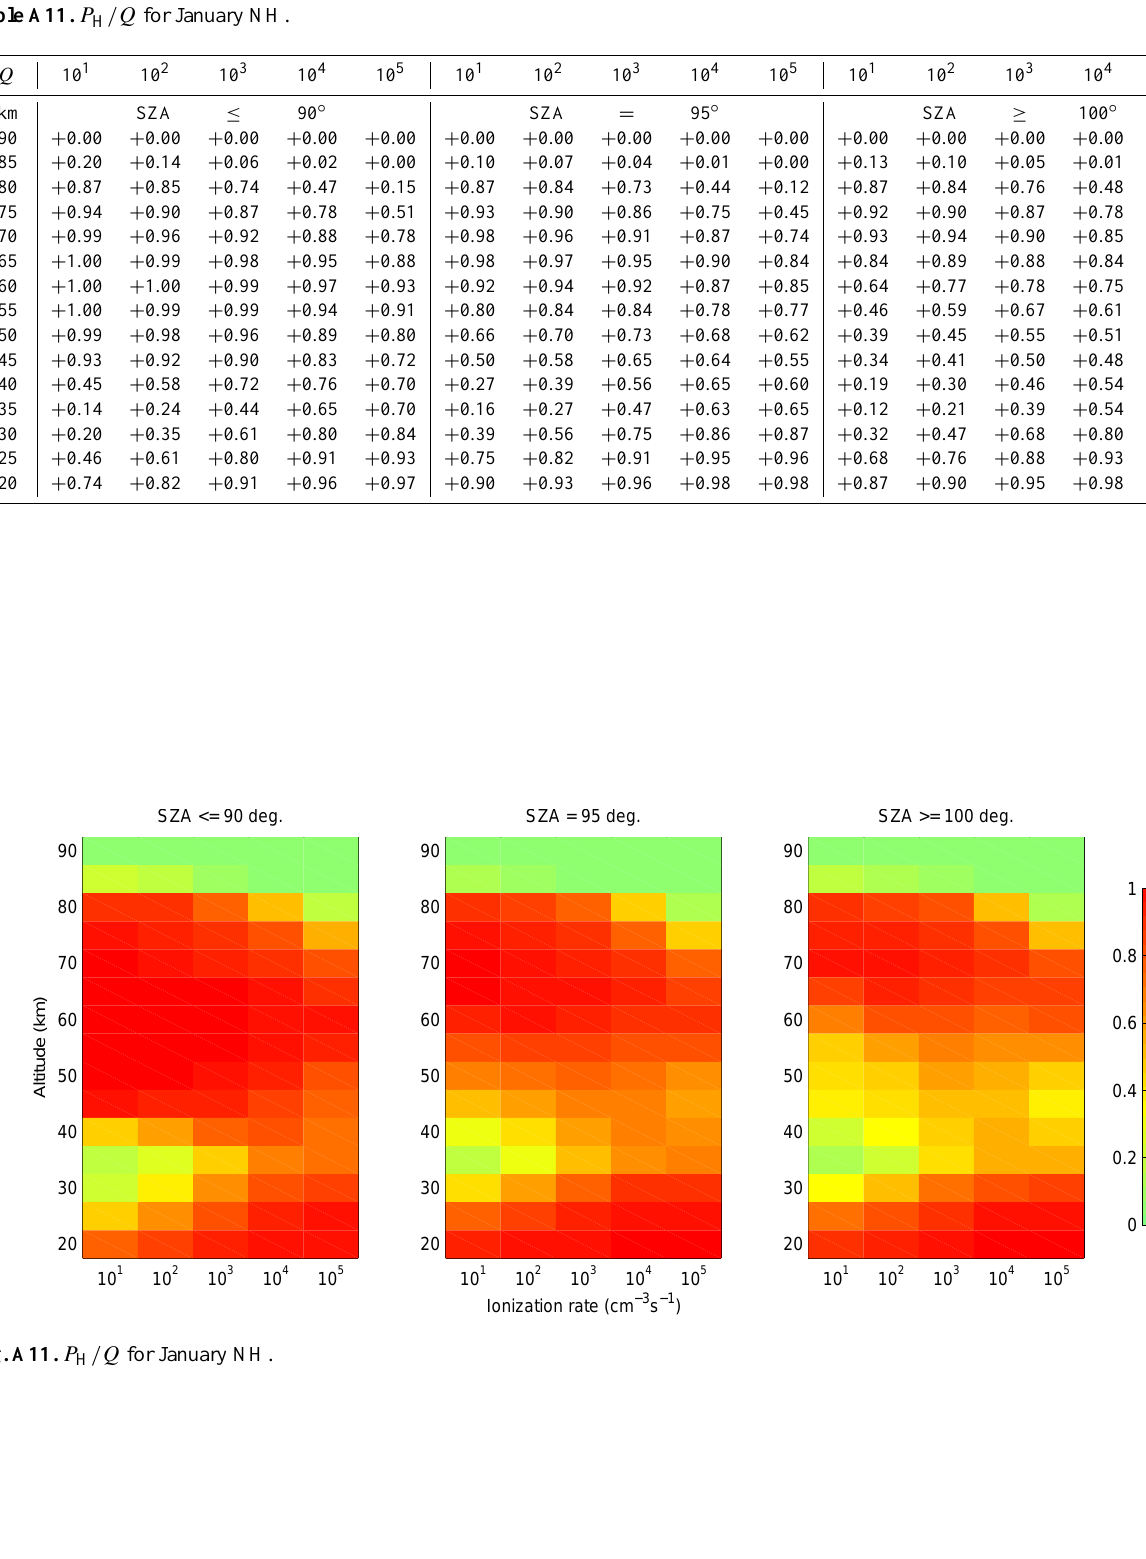
Table A11. P H /Q for January NH.